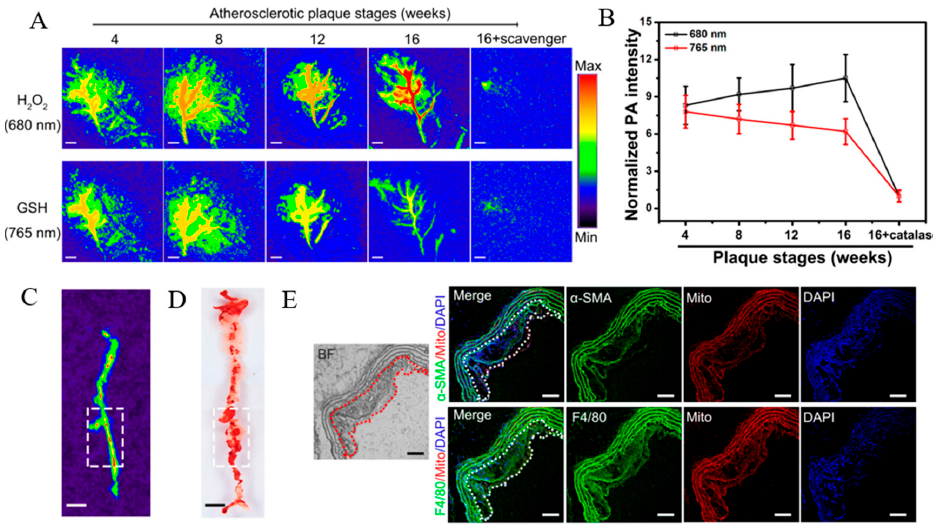
Figure 6. ( A ) PA imaging of atherosclerotic plaques in ApoE − / − mice injected with BSA-Cy-Mito at the indicated stages. ( B ) Normalized PA intensities of plaques at different stages. ( C ) PA imaging at plaque lesions across the aorta of ApoE − / − mice. ( D ) En face aortic lesions in Oil red O-stained aorta. ( E ) Fluorescence microscope images of aortic plaques in ApoE − / − mice. Scale bar = 100 μ m. Adapted from [114].